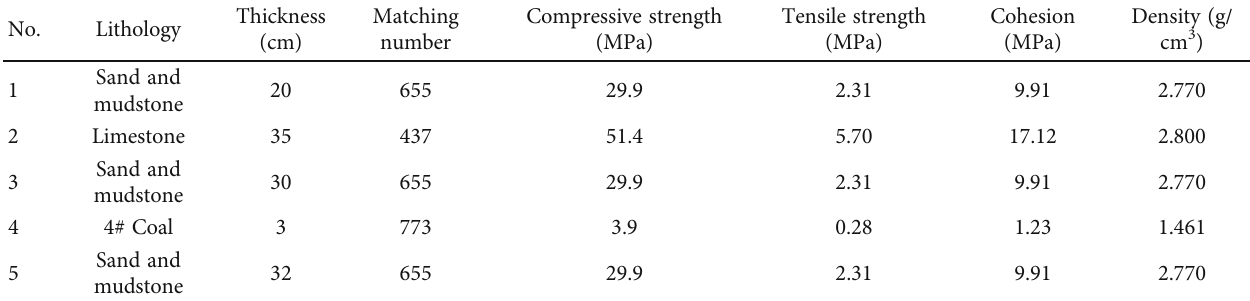
Figure 2: Displacement measuring point arrangement and excavation position. Table 1: Similarity simulation test ratio and